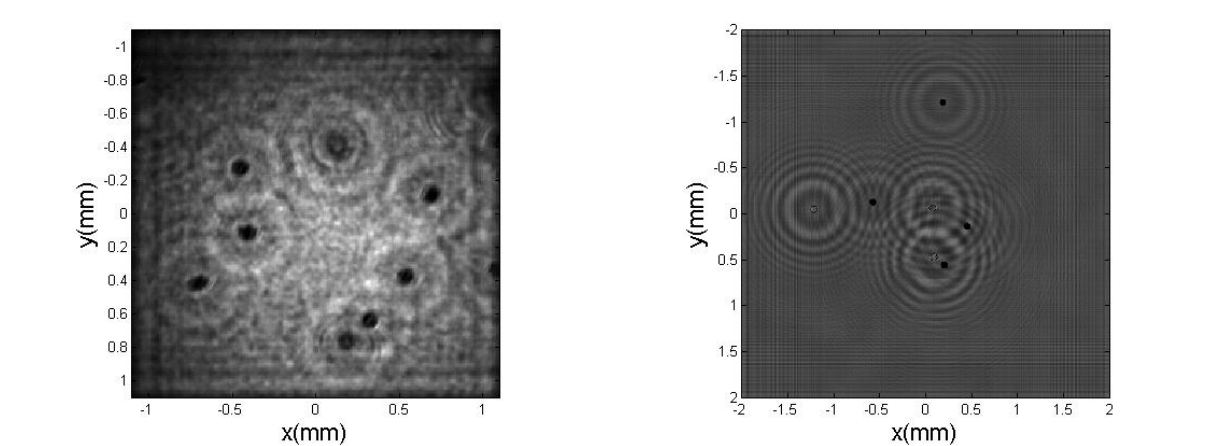
( a ) Experimental reconstruction of inclusions in a droplet; ( b ) Simulated reconstruction of opaque and transparent inclusions in a